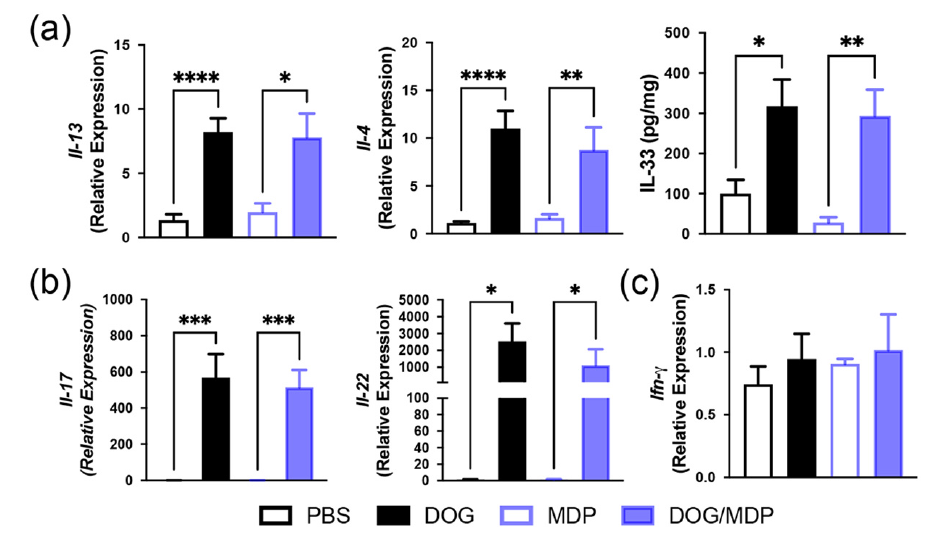
Figure 2. The mixed Th2/Th17-type profile induced by dog allergen remains unchanged under the effect of NOD2 ligand. Relative mRNA expression and protein level of ( a ) Th2 cytokines, ( b ) Th17 cytokines, and ( c ) Th1 cytokine. Cytokines were assessed by quantitative real-time PCR and by ELISA in lung tissues from control and challenged mice. Data are presented as mean ± SEM (n = 5–20 mice per group). * p < 0.05, ** p < 0.01, *** p < 0.001, **** p < 0.0001 versus PBS or MDP. Kruskal–Wallis test for all.